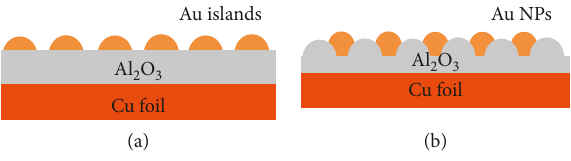
Figure 4: Schematic illustration of filling mechanism for Au films deposited onto the Al 2 O 3 /Cu foils (a) after bombarding with Ar ion and (b) after annealing processes.